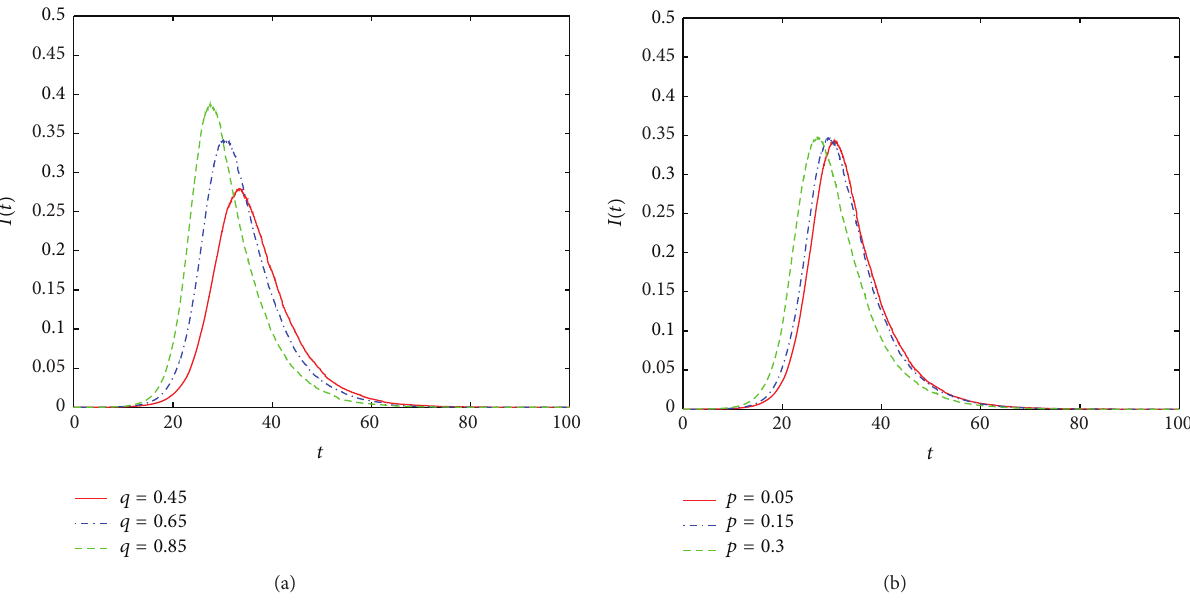
Figure 8: Density of spreaders with different 𝑝 and 𝑞 on BA networks.